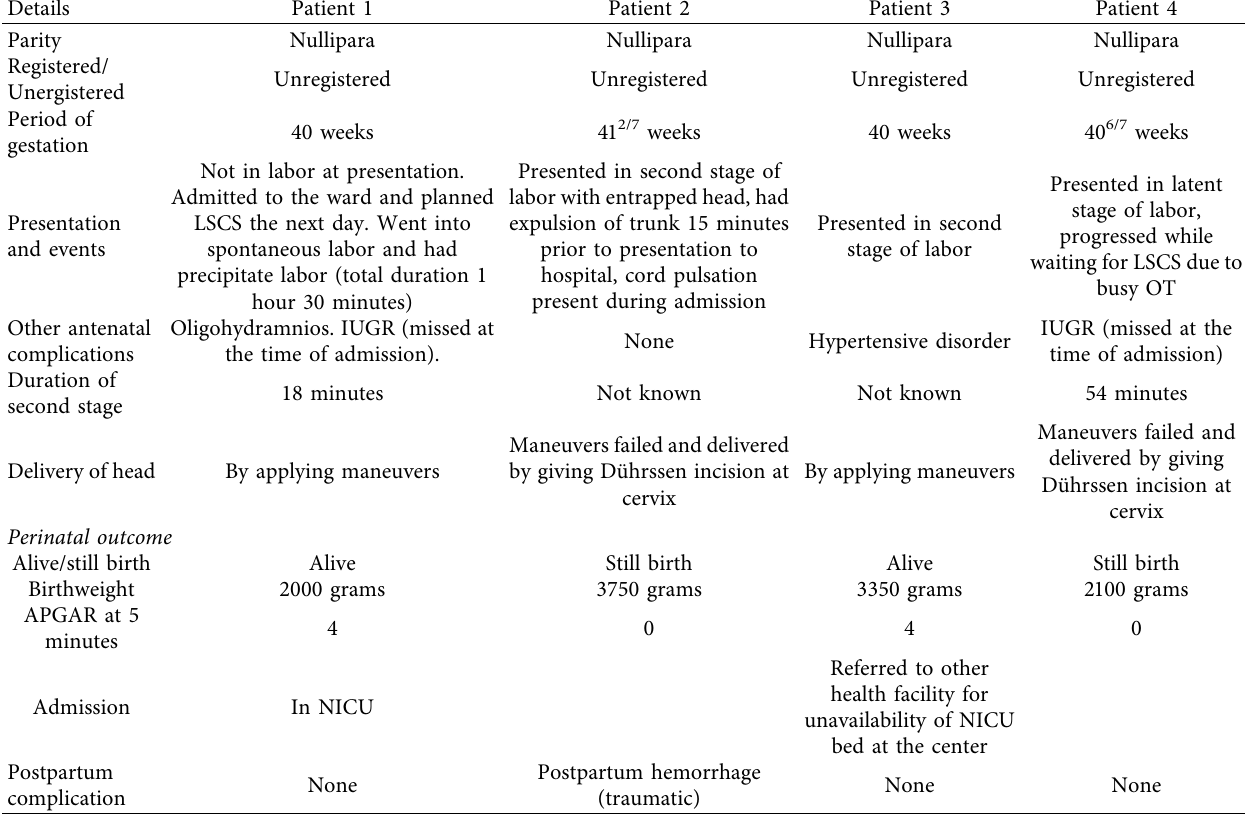
Table 3: Details of women having entrapment of aftercoming fetal head.